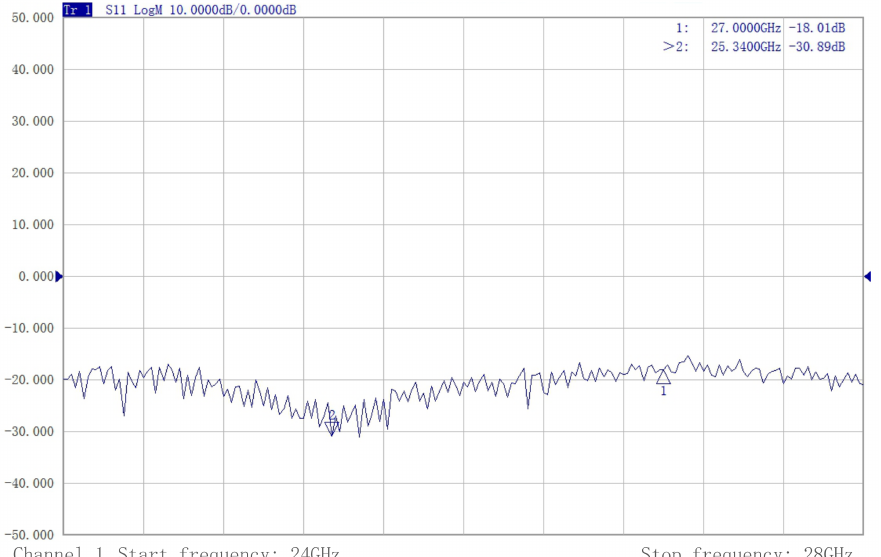
Figure 14. Reflection coefficient test.